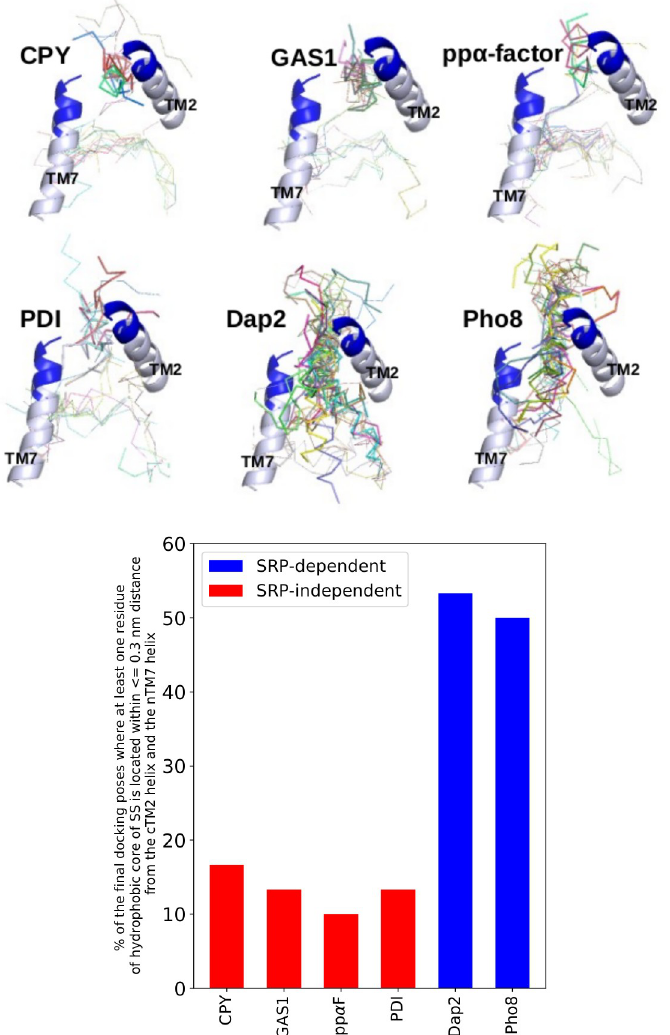
Fig 11. Upper-panel: All final docking poses are represented as line models. The final docking poses which satisfy the distance criterion are shown with thicker lines. TM2 and TM7 of Sec61 are shown in cartoon model. The blue parts of TM2 and TM7 represent the C-terminus of TM2 and the N-terminus of TM7. Instead of the whole Sec61 protein only TM2 and TM7 of Sec61 are shown for clarity. Lower-panel: The percentage of the total final docking poses where at least one residue of the hydrophobic core is located near ( � 0.3 nm residue-residue distance) the C-terminus of TM2 and the N-terminus of TM7. Basically it represents the percentage of conformations which occupy the volume between cTM2 and nTM7 (lateral gate). The pp alpha -factor is abbreviated as pp α